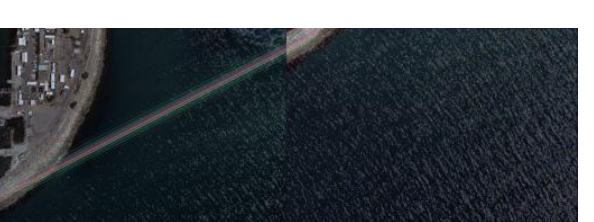
Figure 5c: Matches filtered by RANSAC-fitted